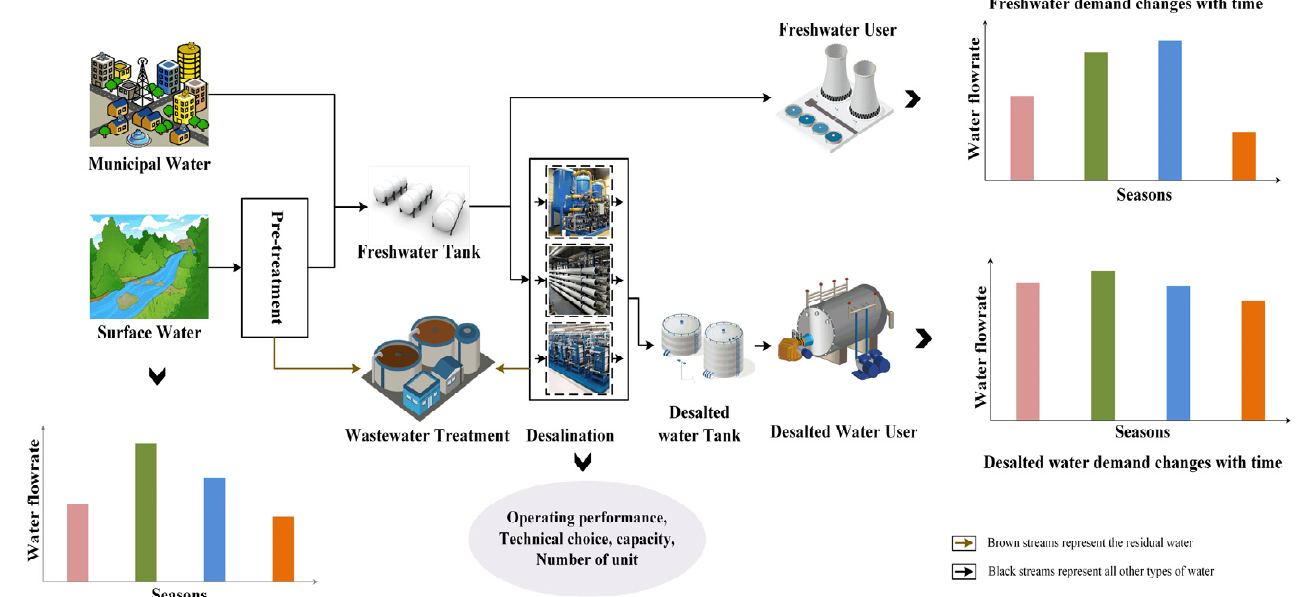
Figure 1. The superstructure of multi-period water supply network.